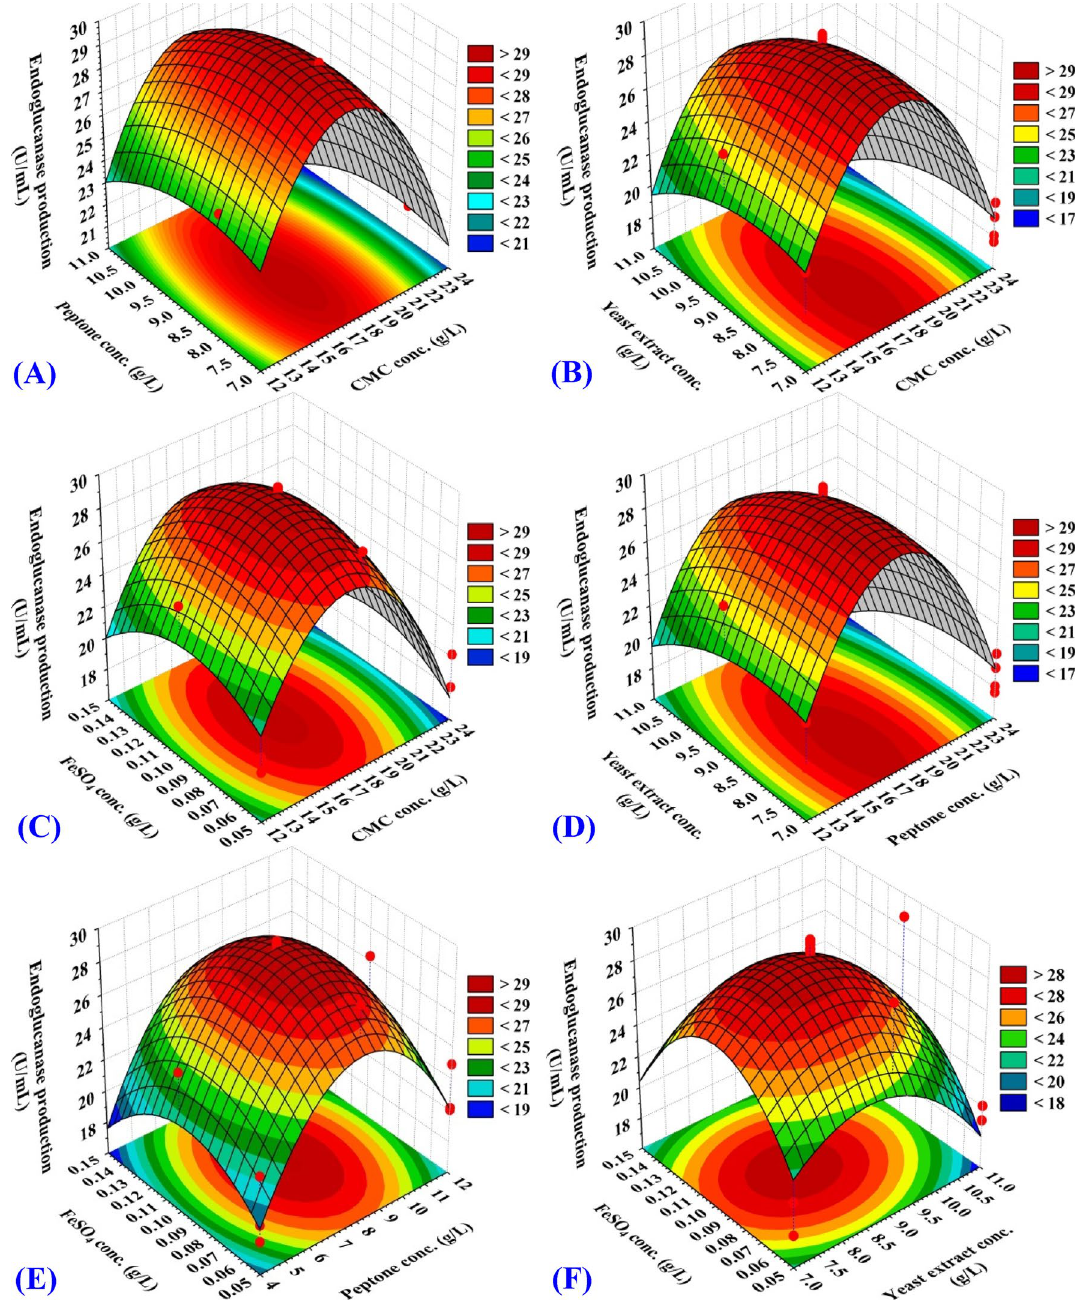
Figure 6. Three-dimensional surface plot for endoglucanase production by Bacillus subtilis strain Fatma/1 as affected by CMC, yeast extract, peptone and FeSO 4